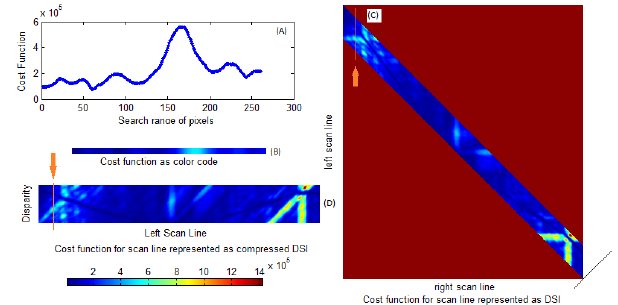
Figure 1: (A) Cost Function, (B) Color coded cost funciton rep- resentation of (A), (C) Disparity Space Image , (D) Compresed Disparity Space Image (arrow shows location of cost function represented by (B))